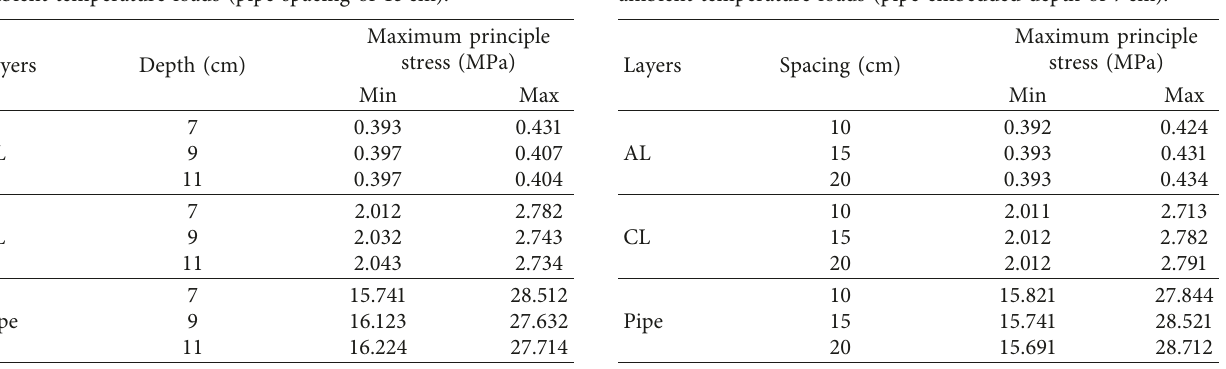
Table 5: Maximum principle stress extreme values of HSMP under ambient temperature loads (pipe embedded depth of